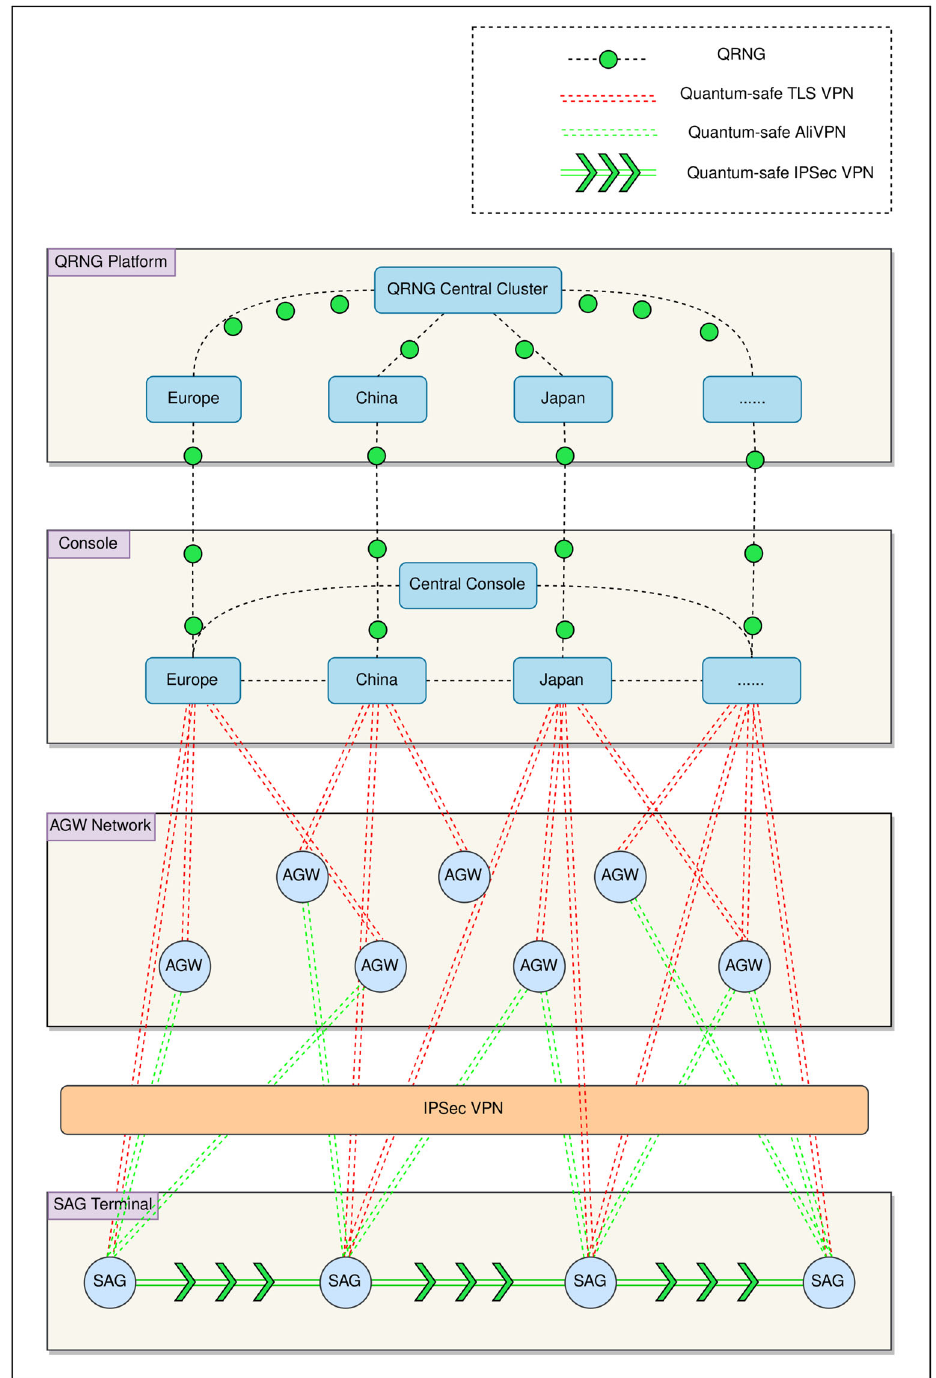
Fig. 3 QRNG in quantum-safe VPNs. Data fl ow of the generated random numbers from Alibaba QRNG Cloud Platform in the Smart Access